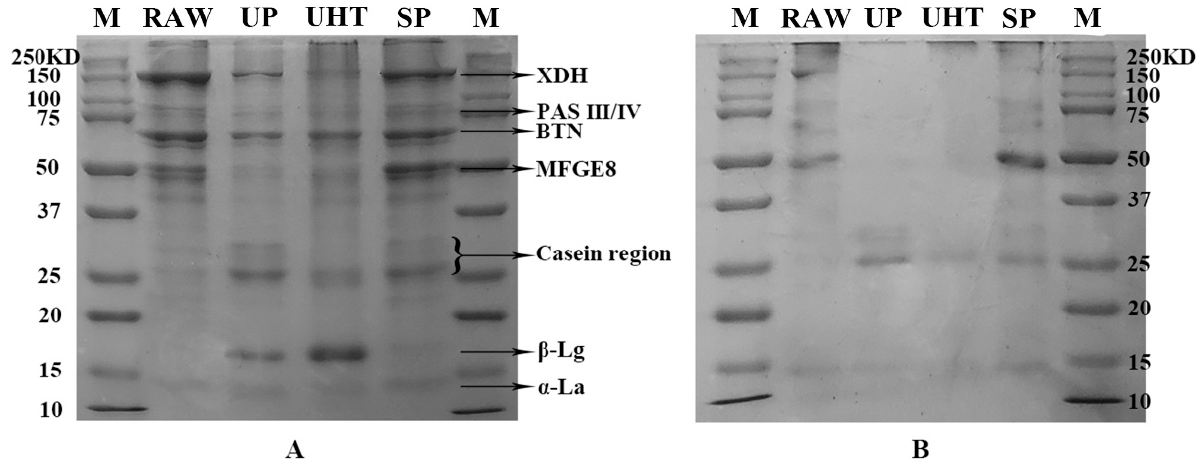
Figure 1. SDS-PAGE images of MFGM proteins from RAW, untreated milk; UP, ultra-pasteurized milk; UHT, ultra-high temperature instant sterilization milk; SP, spray-dried milk with reduced conditions ( A ) and non-reduced conditions ( B ). Line M is the molecular weight standard.